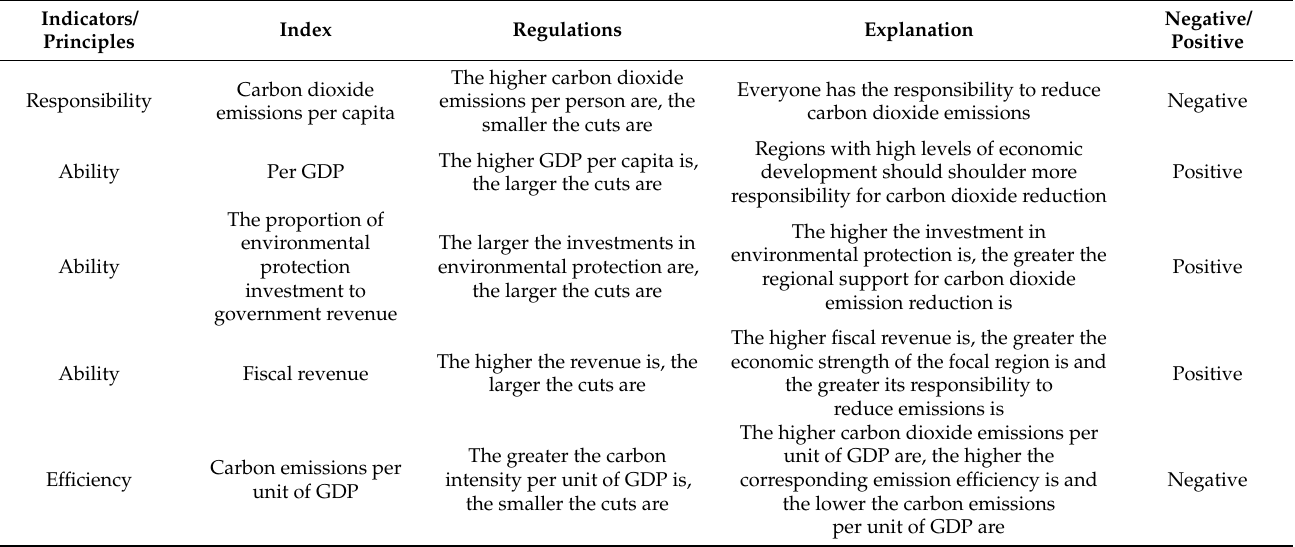
Table 2. Total carbon emission reduction and distribution indicator